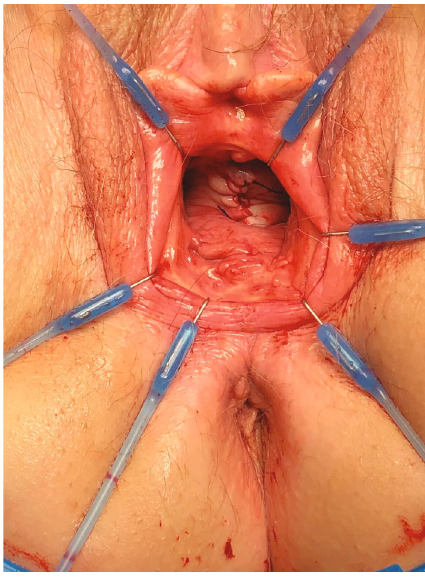
Figure 3: Excellent correction of the anterior wall